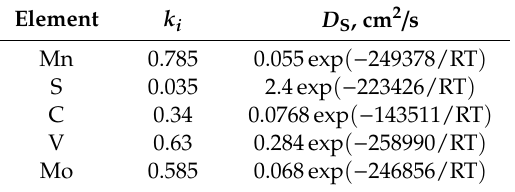
Table 4. Equilibrium partition coe ffi cients ( k i ) and di ff usion coe ffi cients ( D S ) of the studied elements.